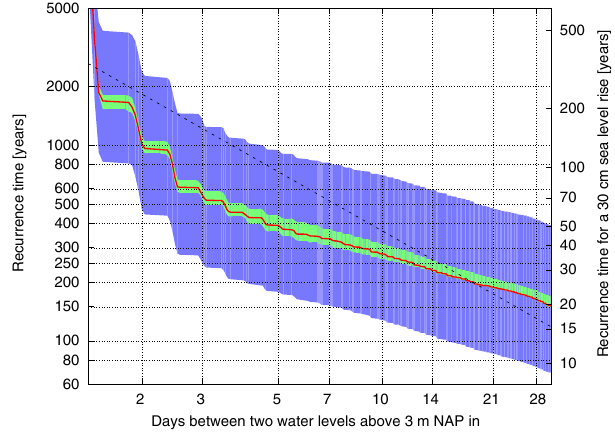
Figure 9. Recurrence times in years as a function of the inter-arrival time for a threshold of 3.0m. The line is determined by counting the events for a threshold of 2.5m and multiplying the probabilities with 0.032 (according to Eq. 12.). The green shading illustrates the effect on the recurrence time if the EDF is based on thresholds in the range of 2.3–2.7m. The blue shading is the 95% confidence interval due to the bias correction of Eq. (10). The dashed line represents the Poisson distribution (Eq. 7) with λ = 0 . 10 per year. The right axis shows the recurrence times for a sea level rise of 30cm. All axes are